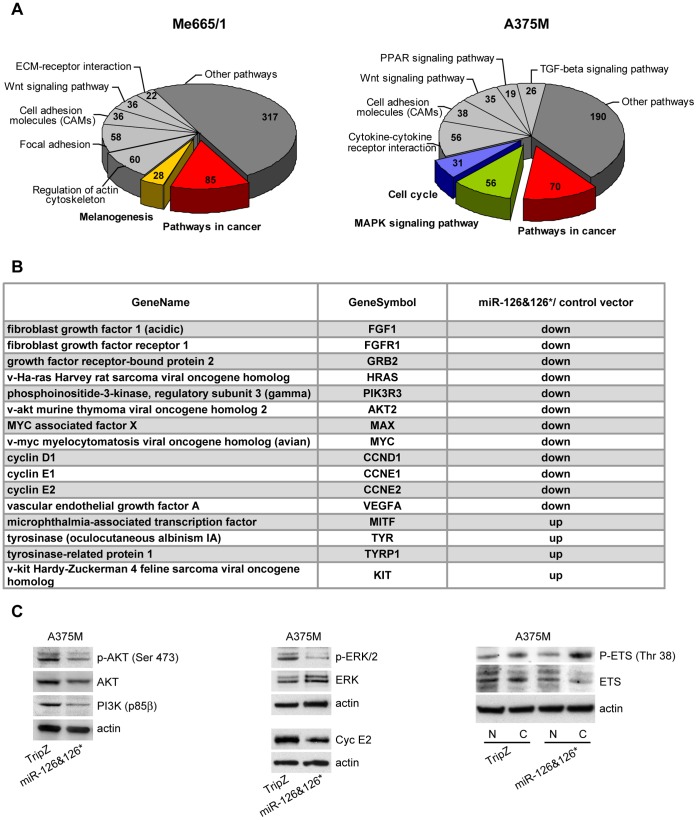
Gene expression profiles. A)KEGG pathway analysis of miR-126&126* associated molecular signatures deriving from Me665/1 and A375M cell lines transduced with miR-126&126* and compared with controls. Up- and down- differentially expressed genes correspond to >2 and <2, respectively. B) A short list of functionally relevant genes modulated by miR-126&126* in Me665/1 and/or A375M. C) WB validation of some selected genes.